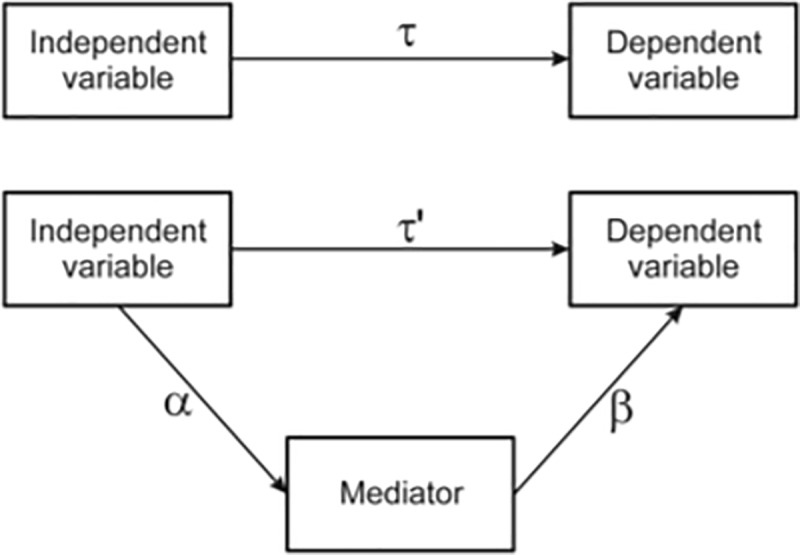
Mediation effects.